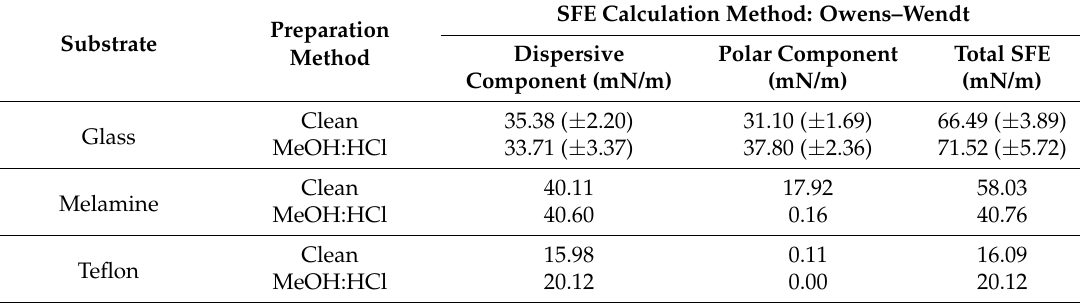
Table 4. Surface Free Energy calculations of clean surfaces before the treatment with the acidic solution (Clean) and after the treatment with the acidic solution (MeOH:HCl 1N).